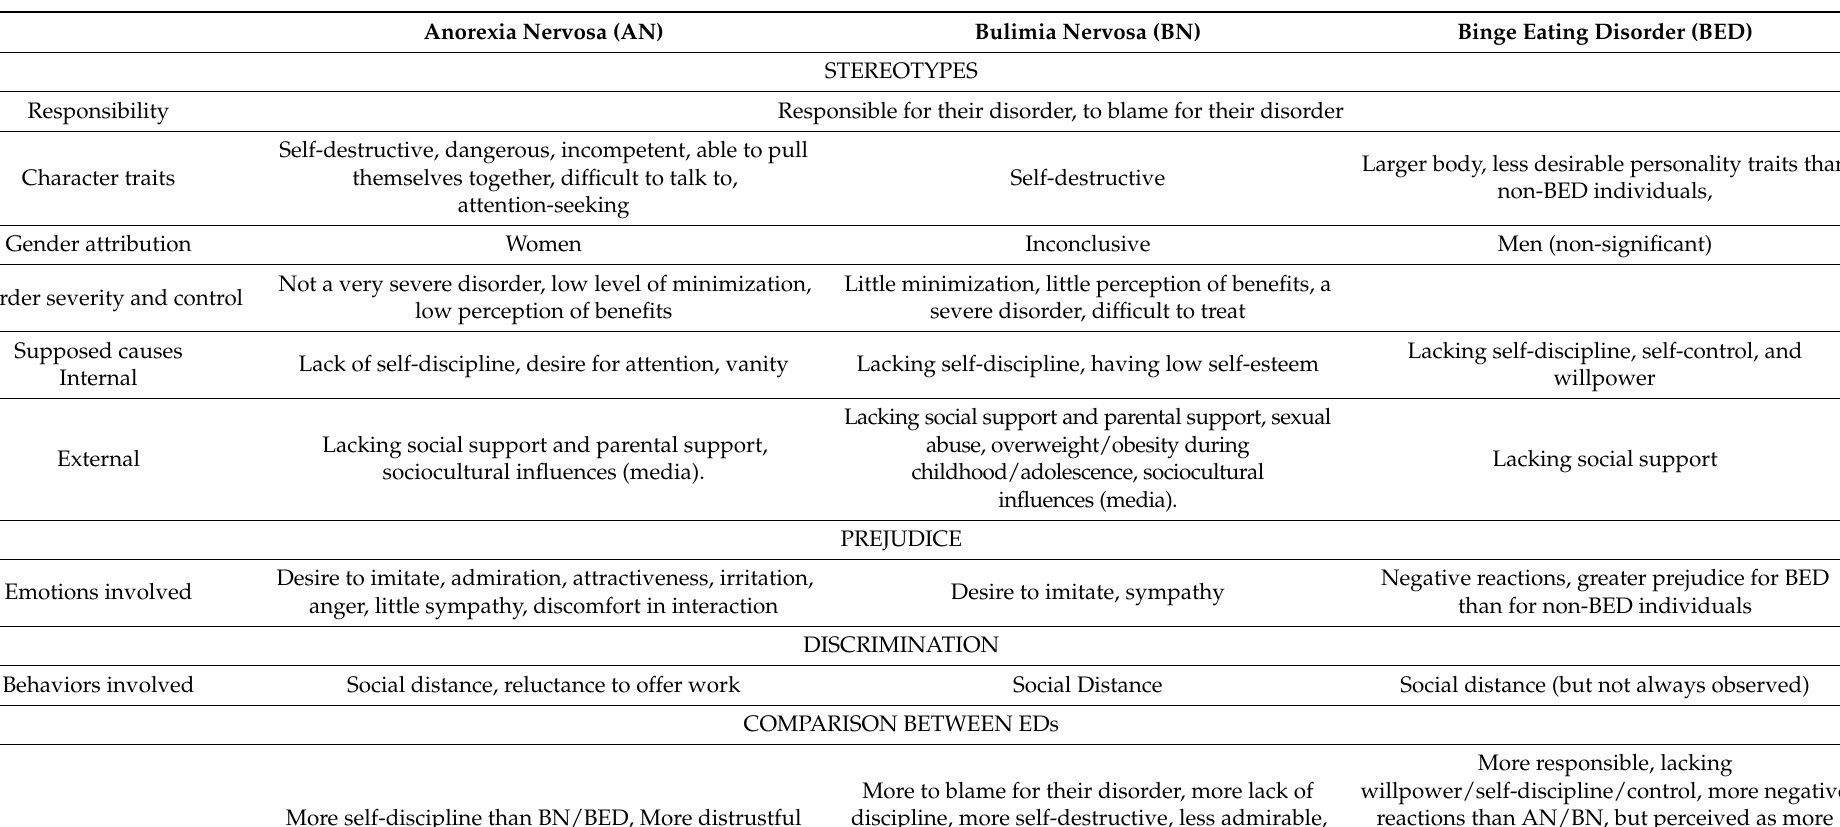
Table A2. Overview of stigma content for each eating